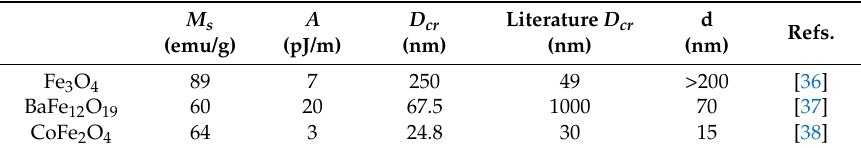
Table 3. Critical sizes of single-domain magnetic Fe 3 O 4 , BaFe 12 O 19 , CoFe 2 O 4 nanoparticles.